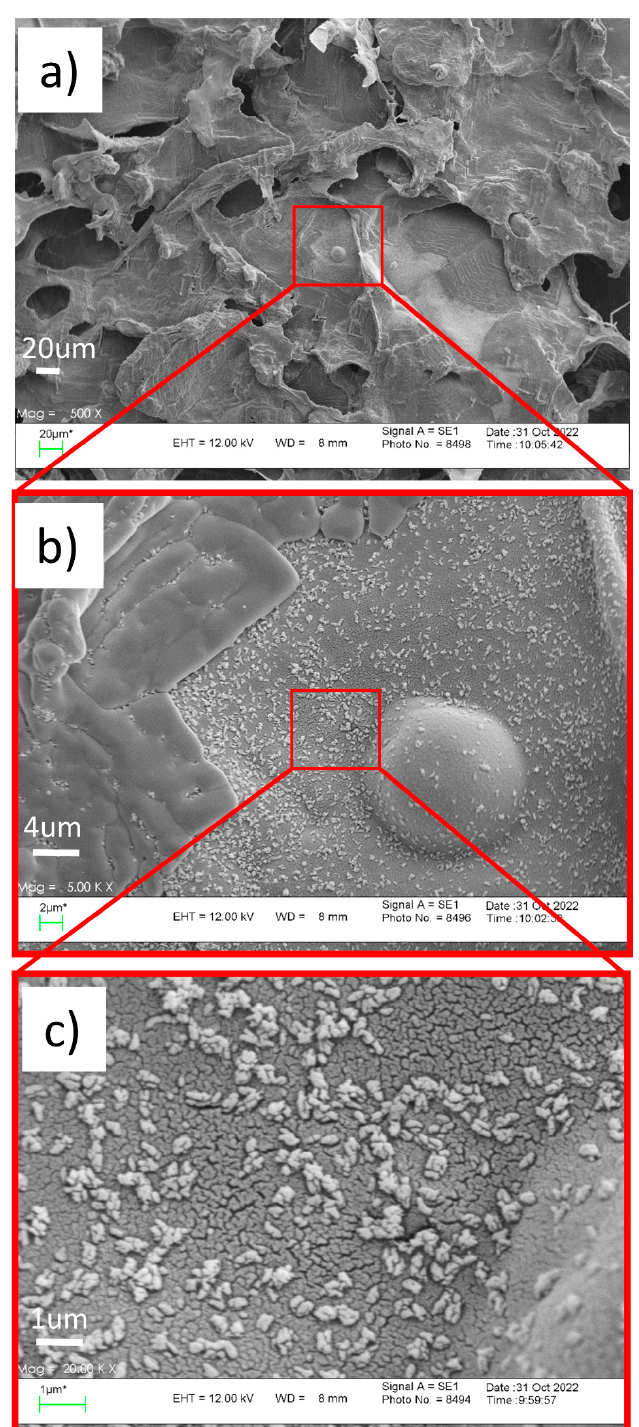
Figure 3. SEM micrograph of the LC sponge containing LCNs/PTX at ( a ) 500X and ( b ) 5000X and ( c ) 20,000X, (LCNs/PTX nanoparticles on the surface of sponge are more visible in the 20,000X image).